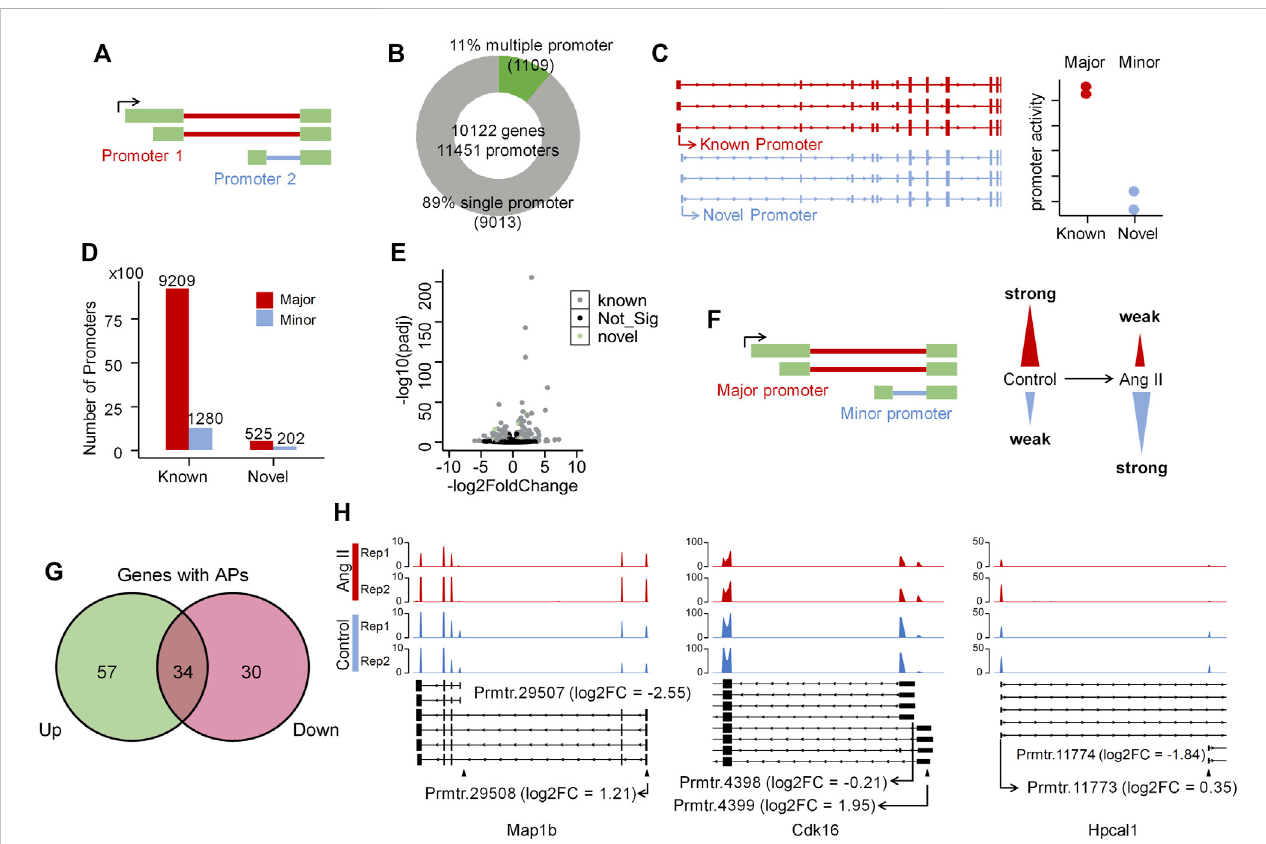
FIGURE 3 Alternative promoter activity analysis before and after Ang II treatment in RAECs. (A) Schematic representation of promoter de fi nition in this study (Demircio ğ lu et al., 2019). (B) Number of single promoter genes and multiple promoter genes identi fi ed in the transcriptome that Iso-Seq generated. (C) Example of known and novel promoters in RAECs. Promoters are considered known if known ncbiRefSeq transcripts also use this promoter. Promoters with the highest average activity are considered Major promoters, and all other promoters of the same gene are assigned as Minor promoters (Huang et al., 2021). (D) The number of Major, Minor promoters in known and novel categories. Most promoters are known and the proportion of novel and minor promoters are small. (E) Differentially expressed promoter analysis in RAECs. Black color stands for not signi fi cantly differentially expressed promoters, gray color stands for signi fi cantly differentially expressed known promoters, and green color stands for signi fi cantly differentially expressed novel promoters. (F) Schematic representation of promoter activity switching. (G) Venn diagram shows the overlap of genes with upregulated (Up) and downregulated (Down) promoters. (H) Examples of genes that undergo dynamic changes in alternative promoter activity, alternative promoter was marked with ▲